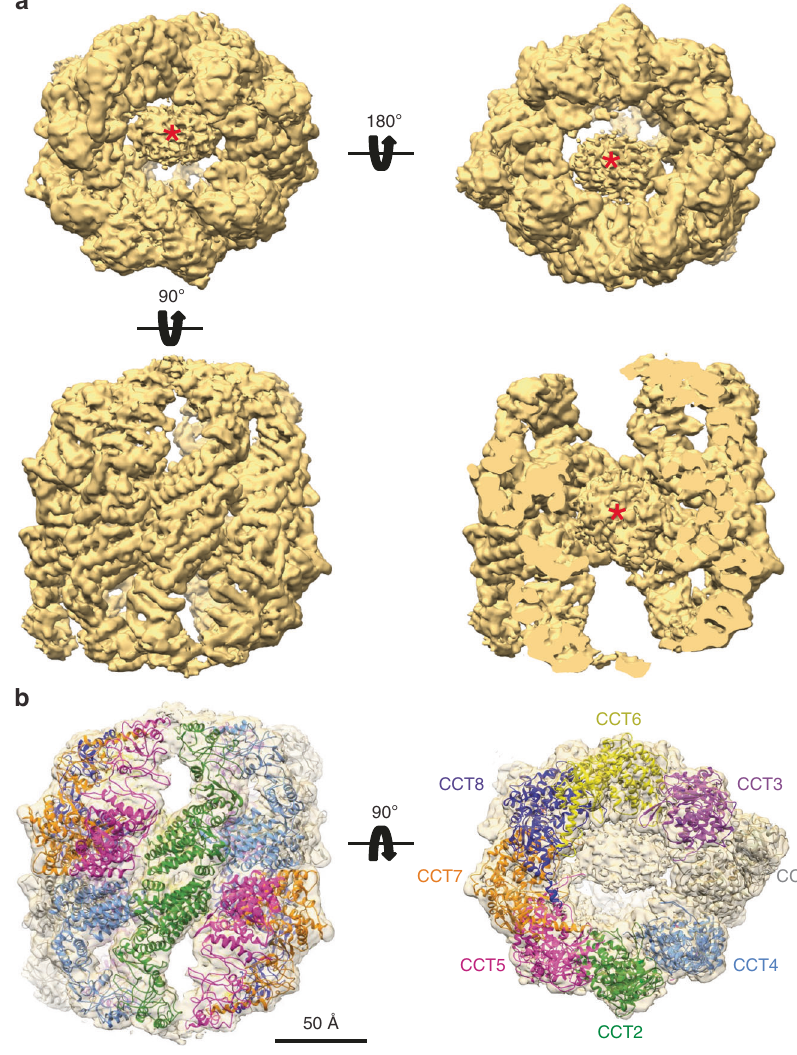
Fig. 3 Cryo-EM structure of the mLST8 – CCT complex. a Top, the two end-on views of the 3D reconstruction of the mLST8 – CCT complex. Bottom, side view of the complex, either intact (left) or sliced through the center of the mass (right), to show the presence of the mLST8 molecule (red asterisks). b Docking of the human CCT atomic model into mLST8 – CCT 3D reconstruction. The color scheme for the CCT subunits is kept the same in all the fi gures. Bar indicates 50